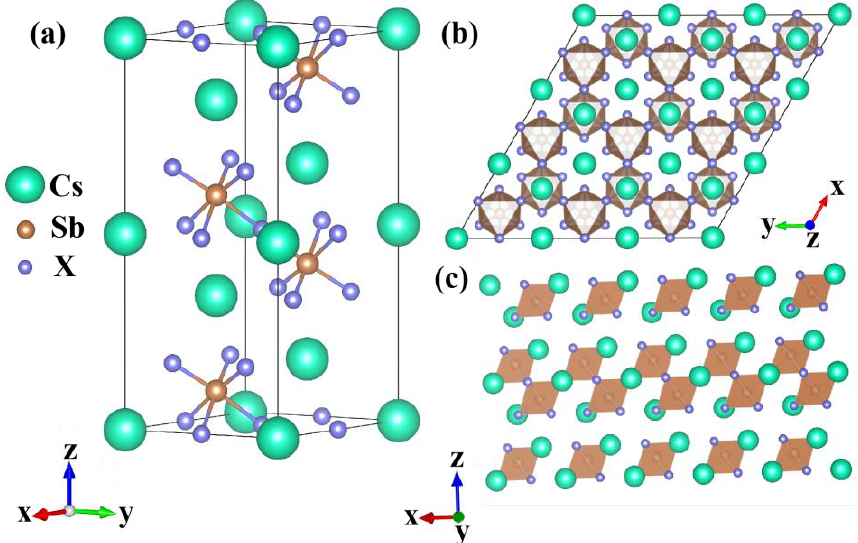
Figure 1. ( a ) Optimized structure of Cs 3 Sb 2 X 9 ; ( b ) corresponding crystal structure of Cs 3 Sb 2 X 9 viewed in the xy plane; ( c ) layered form Cs 3 Sb 2 X 9 .